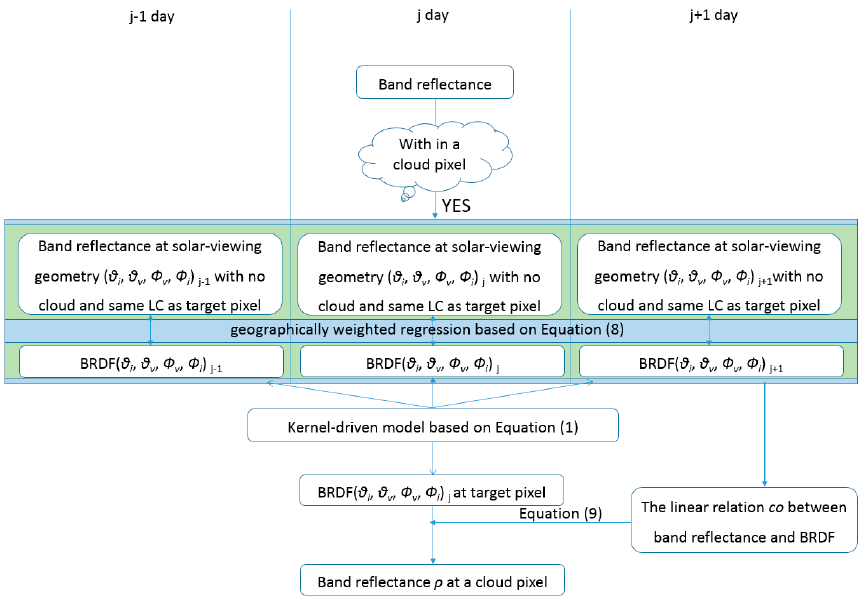
Figure 1. A flowchart of the proposed method.